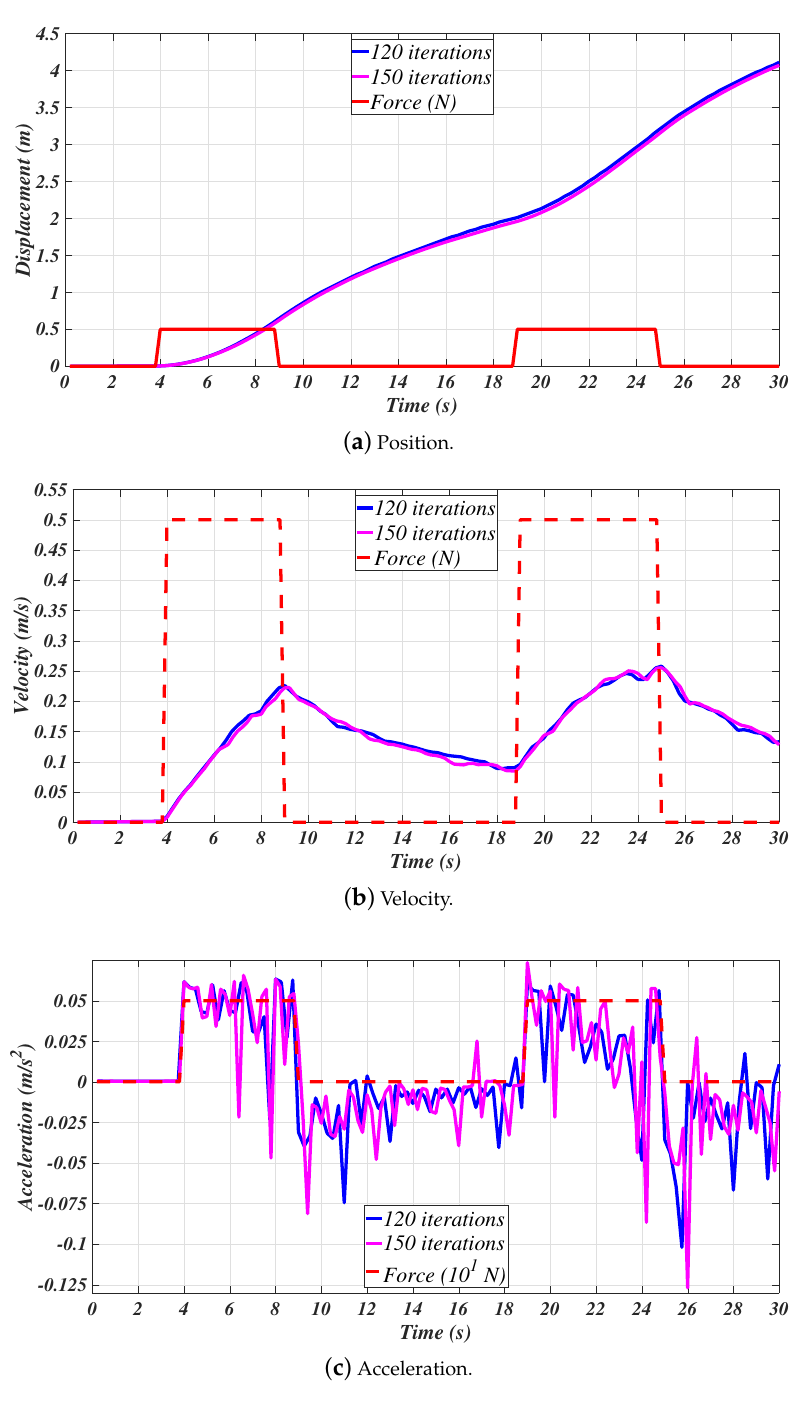
Figure 4. Surge ( b x )